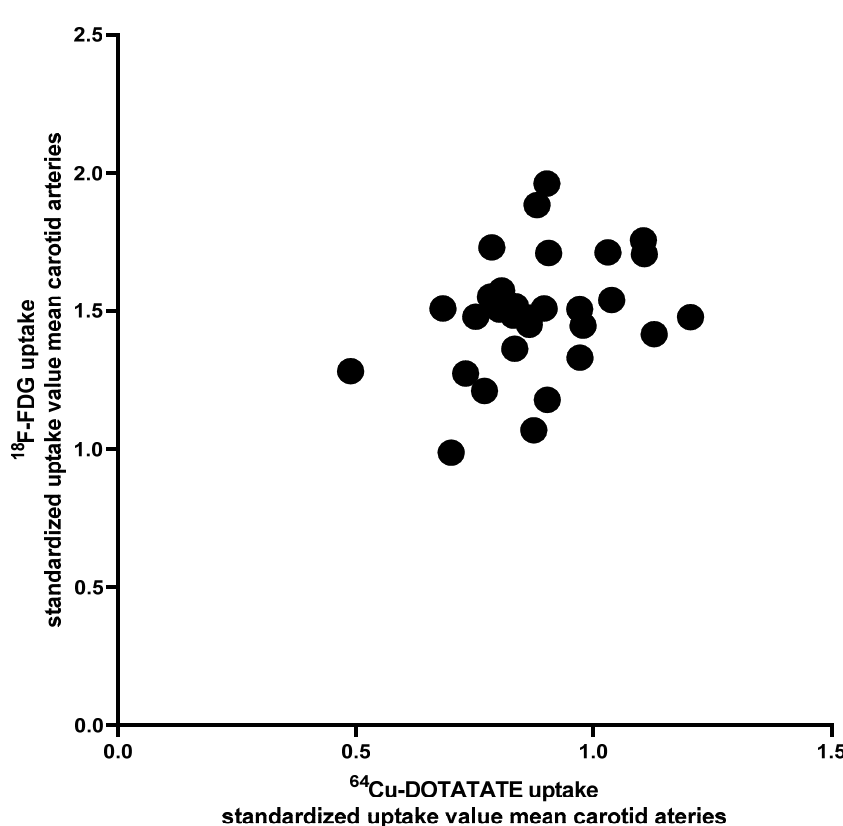
Figure 4. Correlation between [ 64 Cu]DOTATATE and [ 18 F]FDG PET uptake evaluated as mean standardized uptake value in the carotid arteries. Linear regression analysis revealed R 2 = 0.11 and no correlation between the two measures ( p = 0.07, evaluated by F-test).